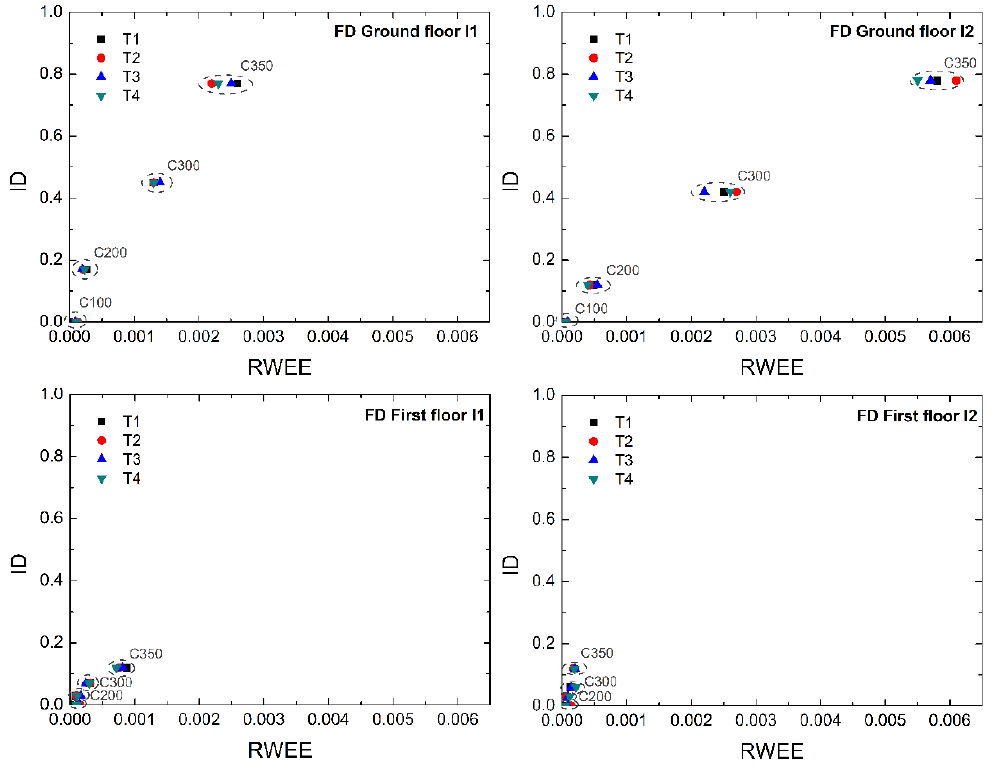
Figure 9. The relative wavelet energy entropy index (RWEE) vs. mechanical damage index (ID) for each I ‐ section of the dampers of FD.